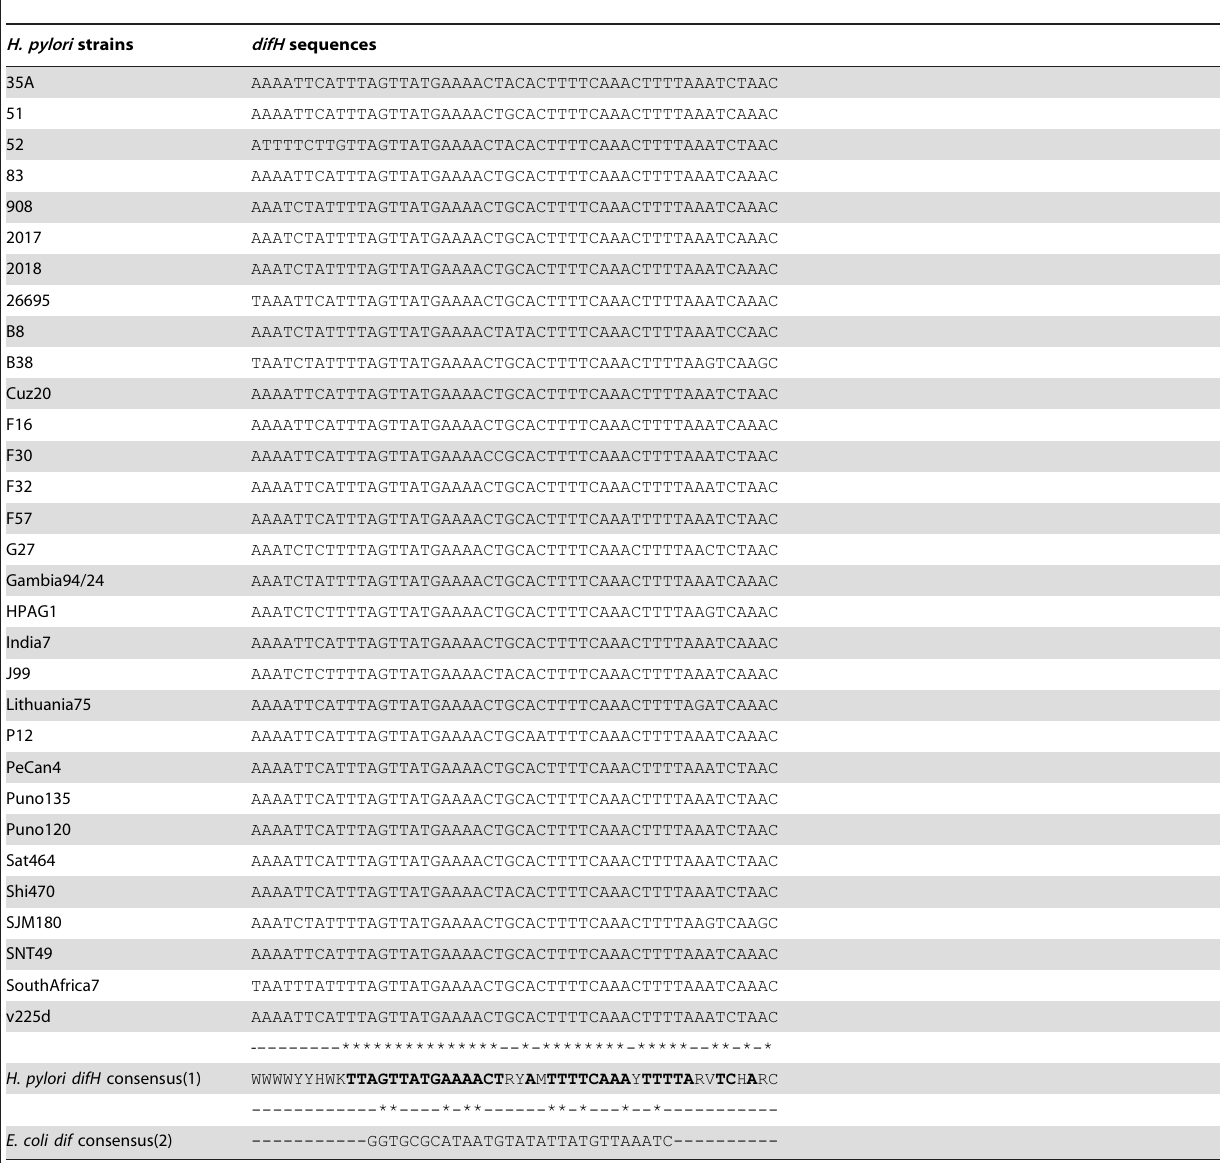
Table 1. Consensus difH sequence obtained from complete H. pylori